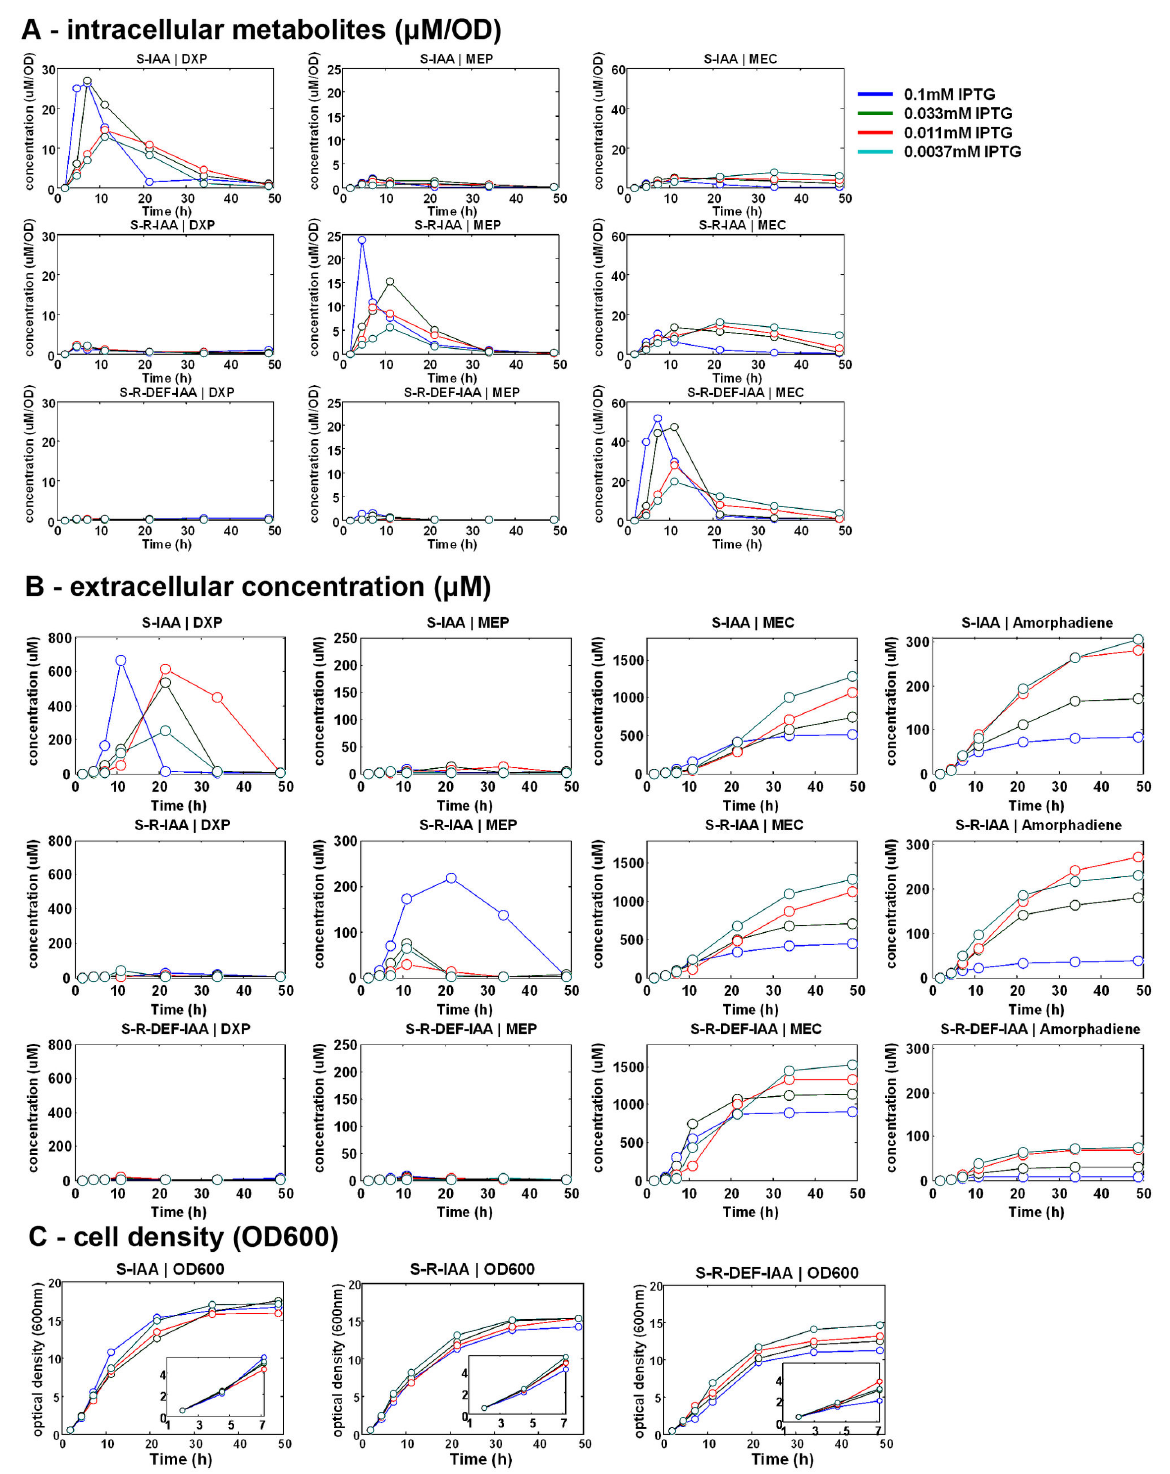
Figure 5. The kinetics of S-IAA-PAC, S-R-IAA-PAC and S-R-DEF-IAA-PAC strains. ( A ) The specific concentration (μM/OD) of intracellular metabolites: DXP, MEP and MEC. The rest of the metabolites were accumulated at concentrations lesser than 2µM/OD and were neglected. ( B ) The concentration of extracellular metabolites: DXP, MEP, MEC and amorphadiene. The rest of the metabolites were accumulated at concentrations lesser than 50µM and were neglected. ( C ) The cell density. doi: 10.1371/journal.pone.0079557.g005 PLOS ONE |